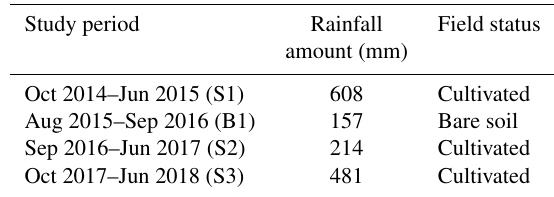
Table 1. Characteristics of the study